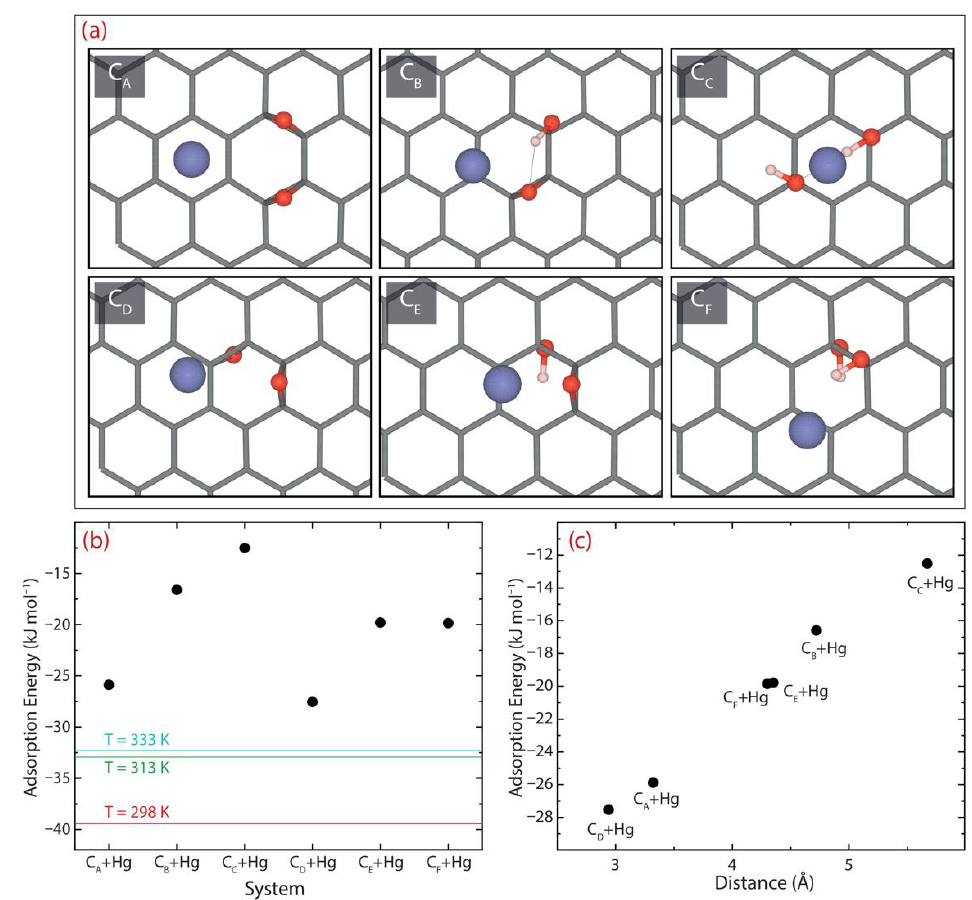
Figure 11. ( a ) Optimized pristine rGO structures obtained by DFT calculations and the six stable configurations of rGO covered by hydroxyl and epoxy groups interacting with the Hg atom. ( b ) The adsorption energy of the six interacting Hg-rGO systems. For comparison, the Gibbs free energy at different temperatures has been included (Table 6). ( c ) Adsorption energy as a function of the interaction distance between the Hg atom and rGO surface.